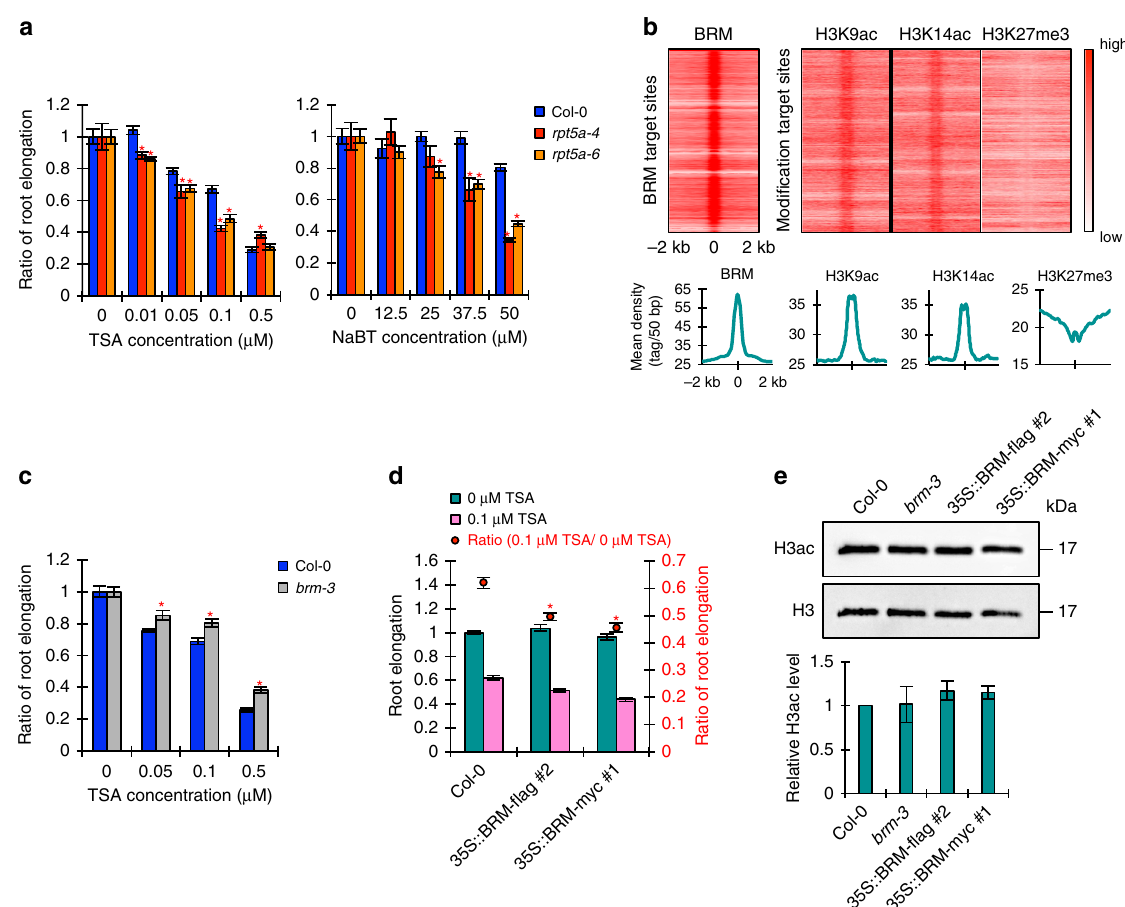
Fig. 10 The negative effects of histone hyperacetylation are dependent on the BRM level. a Sensitivity of Col-0 and rpt5a mutant root growth to histone hyperacetylation caused by TSA or NaBT. Values are ratios relative to the values under each normal condition ( n = 15 – 19, average ± s.e.m.; * P < 0.05, compared with Col-0, Student ’ s t -test). b Heat map representation of the co-occupancy of BRM and histone modi fi cations in the genome. Each horizontal line represents a BRM- or histone modi fi cation-enriched region, and the signal intensity shows the strength of BRM binding to those regions. Columns show the genomic region surrounding each target peak summit. Signal intensity is indicated by the shade of red. The lower panels show the mean density of BRM occupancy at sites of BRM binding and the indicated histone modi fi cations. c Sensitivity of Col-0 and brm-3 root growth to histone hyperacetylation caused by TSA. Values are ratios relative to the values under each normal condition ( n = 25 – 27, average ± s.e.m.; * P < 0.05, compared with Col-0, Student ’ s t -test). d Sensitivity of root growth of Col-0 and BRM high-expression plants to histone hyperacetylation caused by TSA. Values for root elongation are ratios relative to the value of Col-0 under 0 μ M TSA conditions. Red circles represent ratios relative to the value under 0 μ M TSA conditions ( n = 24, average ± s.e.m.; * P < 0.05, compared with Col-0, Student ’ s t -test). e Histone acetylation levels in roots of brm-3 and BRM high-expression plants under normal B conditions. The lower panel shows the relative level of acetylated histone H3 accumulation normalized against total histone H3 ( n = 4, average ±